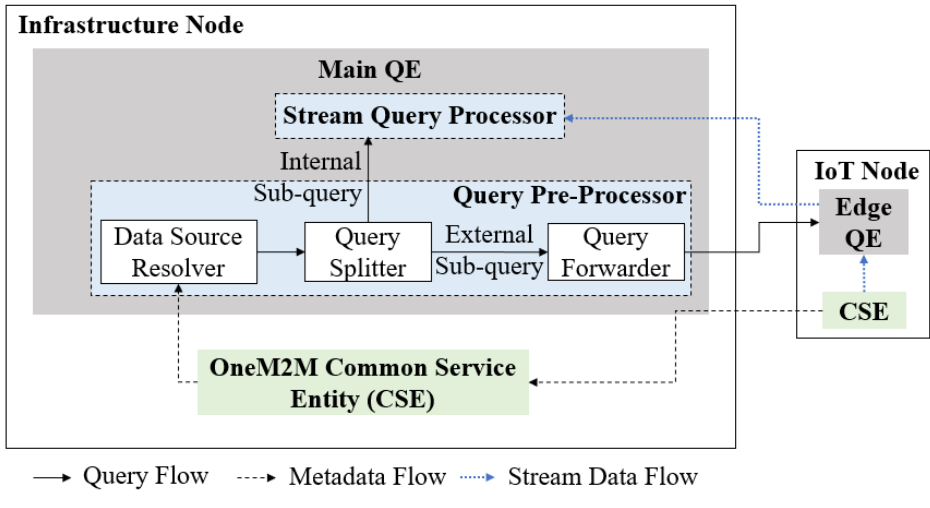
Figure 8. Query Pre-Processor